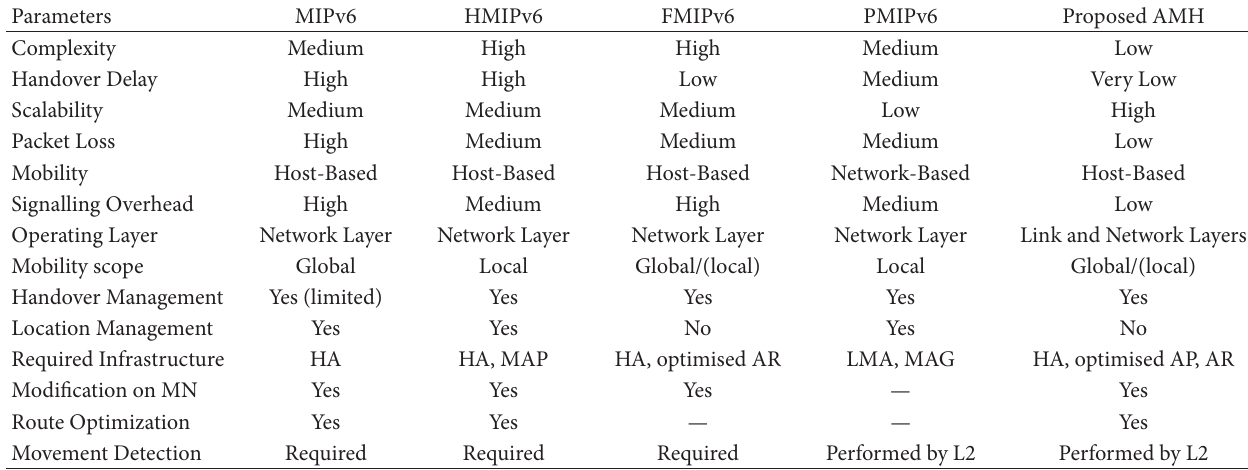
Table 10: Comparison Between Main Mobility Management Protocols and Proposed AMH